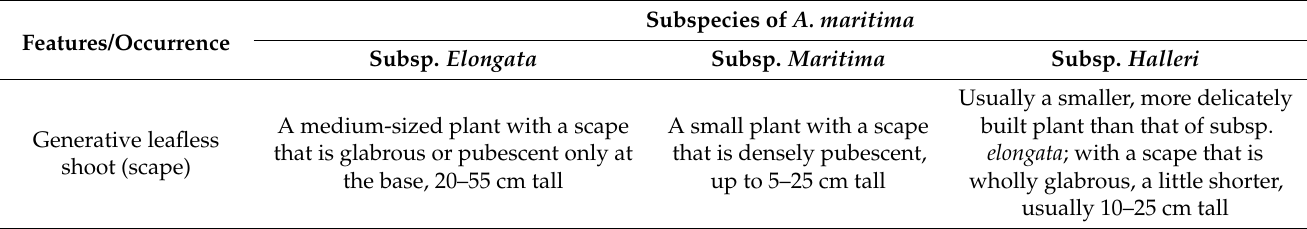
Table 1. Comparison of the appearance, morphology, and occurrence of three selected subspecies of A. maritima (based on: Szafer, 1946 [71]; Pinto da Silva, 1972 [69]; Lef è bvre, 1974 [76]; Woodell